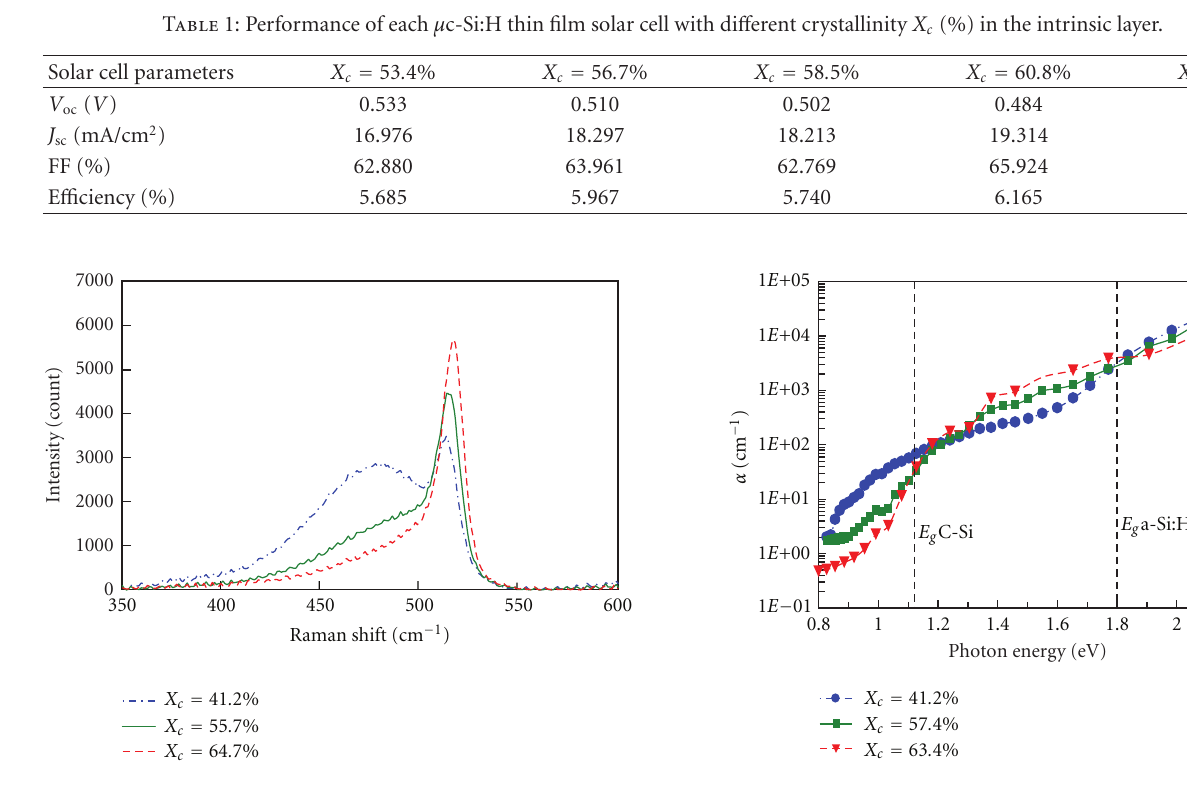
Figure 1: Raman spectra of μ c-Si:H thin films with di ff erent crystalline volume fractions.